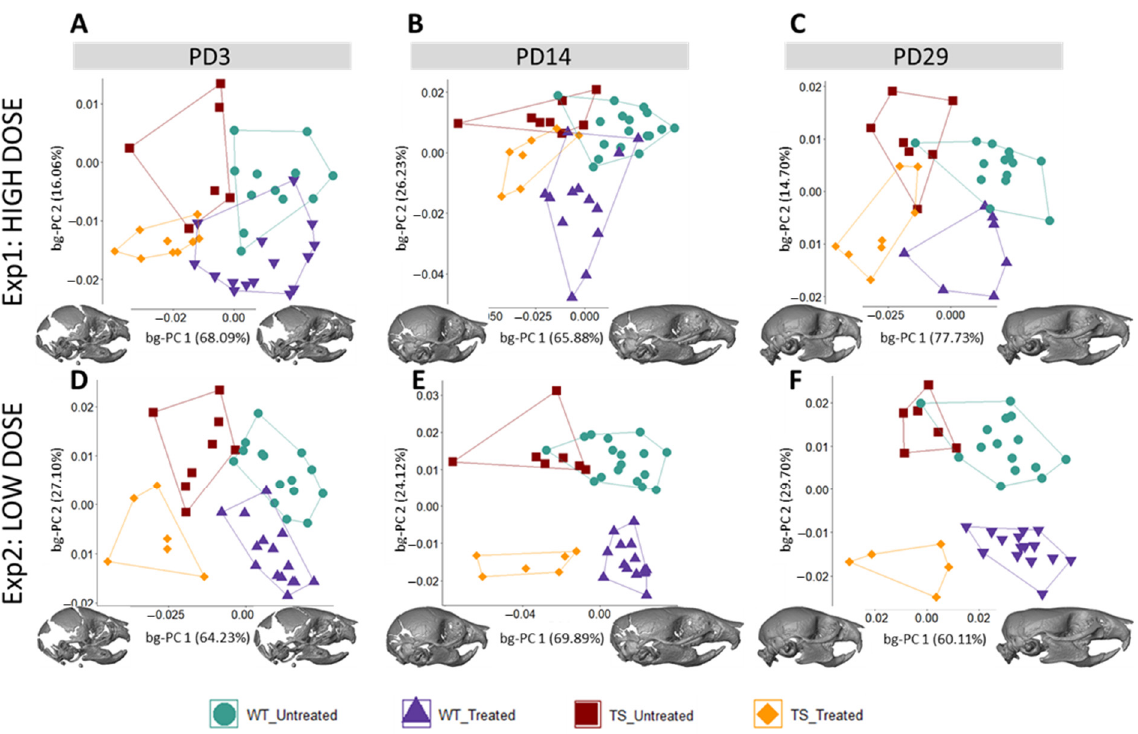
Figure 3. Postnatal skull shape differences between wildtype and trisomic mice across development and the effects of high ‐ and low ‐ dose GTE ‐ EGCG treatment. Skull shape variation as shown by a between ‐ group principal component analysis (bg ‐ PCA) based on the 3D coordinates of landmarks placed on the surfaces of 3D skull reconstructions from in vivo μ CT scans, as described in Supple ‐ mentary Table S4 at ( A , D ) PD3, ( B , E ) PD14, and ( C , F ) PD29. Longitudinal data from experimental setting 1 are presented at the top, whereas data from experimental setting 2 are presented at the bottom. All scatter plots are presented along with the morphings associated with the negative and positive extremes of the bg ‐ PC1 axis. Sample size: Experimental setting 1: (PD3) WT = 12, TS = 6, WT treated = 15, TS treated = 9; (PD14) WT = 17, TS = 8, WT Treated = 13, TS Treated = 7; (PD29) WT = 14, TS = 7, WT treated = 7, TS treated = 8. Experimental setting 2: (PD3) WT = 15, TS = 8, WT treated = 15, TS treated = 6; (PD14) WT = 17, TS = 7, WT treated = 15, TS treated = 6; (PD29) WT = 15, TS = 6, WT treated = 15, TS treated = 5.